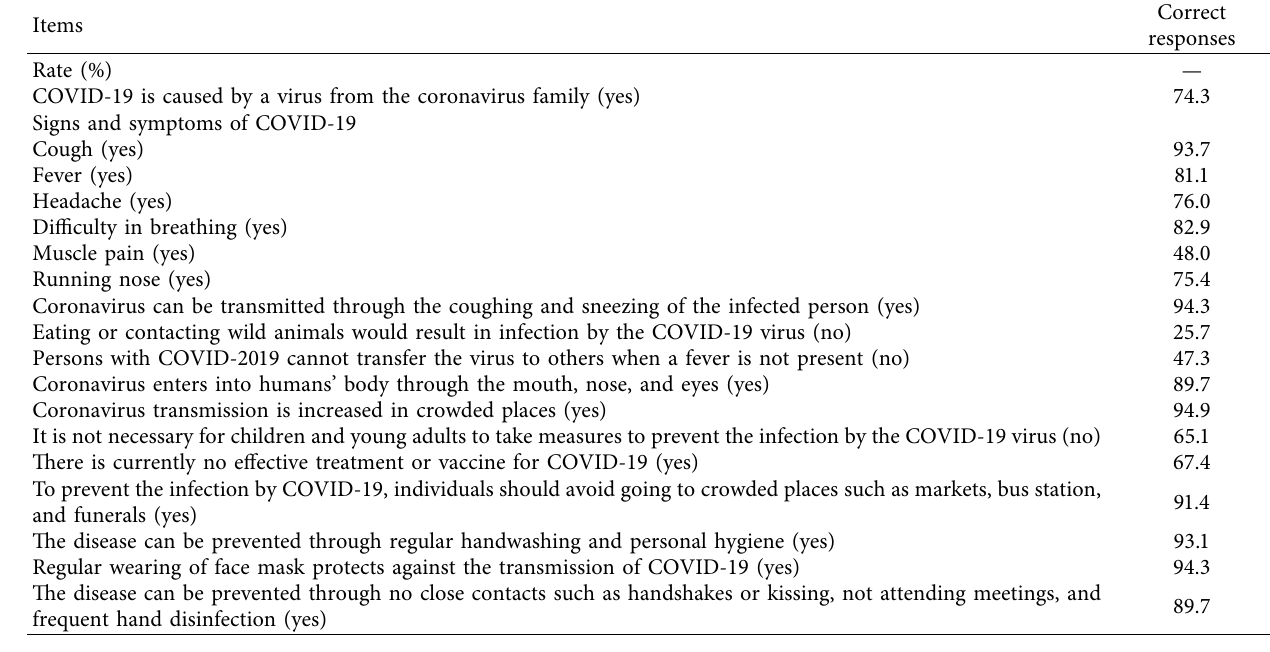
Table 2: Knowledge of students at Tamale Technical Institute towards COVID-19.